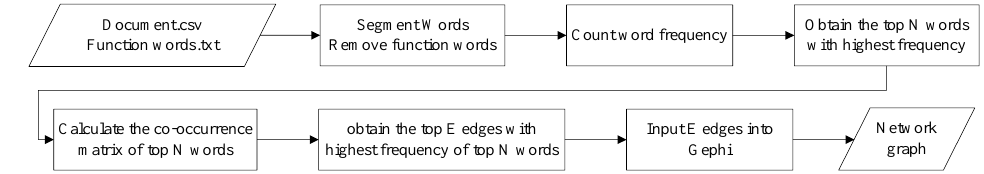
Figure 1. Process of constructing the co-occurrence network of high-frequency words.